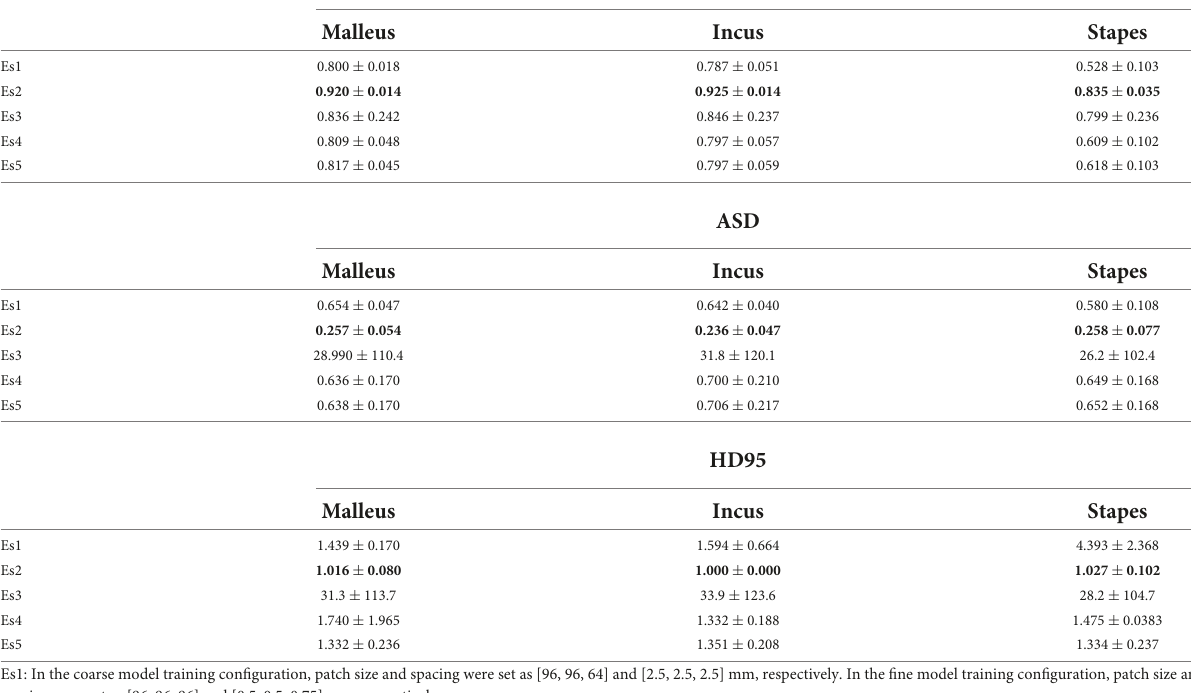
TABLE 2 Comparison of segmentation performance between different experiment settings (patch size, patch spacing) under 3D V-Net. DSC Malleus Incus Stapes